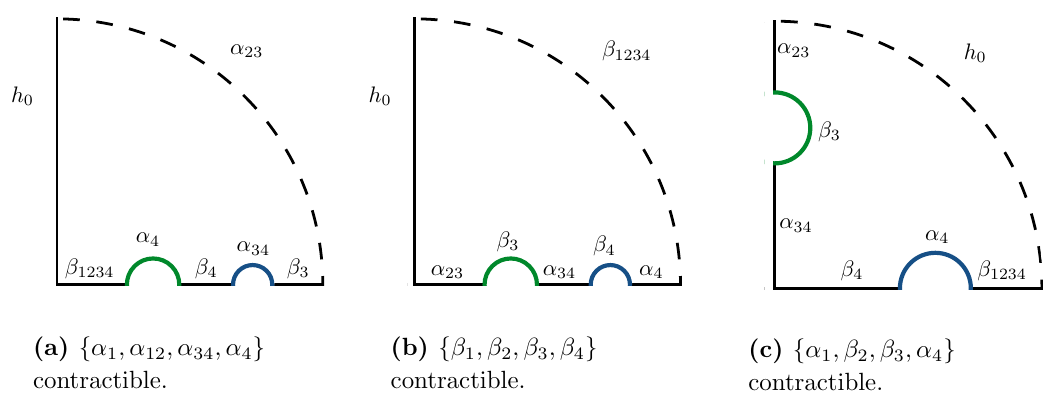
Figure 12 . One eighth of the Schottky domain used to construct the three genus 0 phases (0 a ; 0 b ; 0 c ) reduced by the re(cid:13)ection symmetries in the x-axis and y-axis and the inversion symmetry through the unit circle (dashed). Various boundary cycles are labeled in each phase.